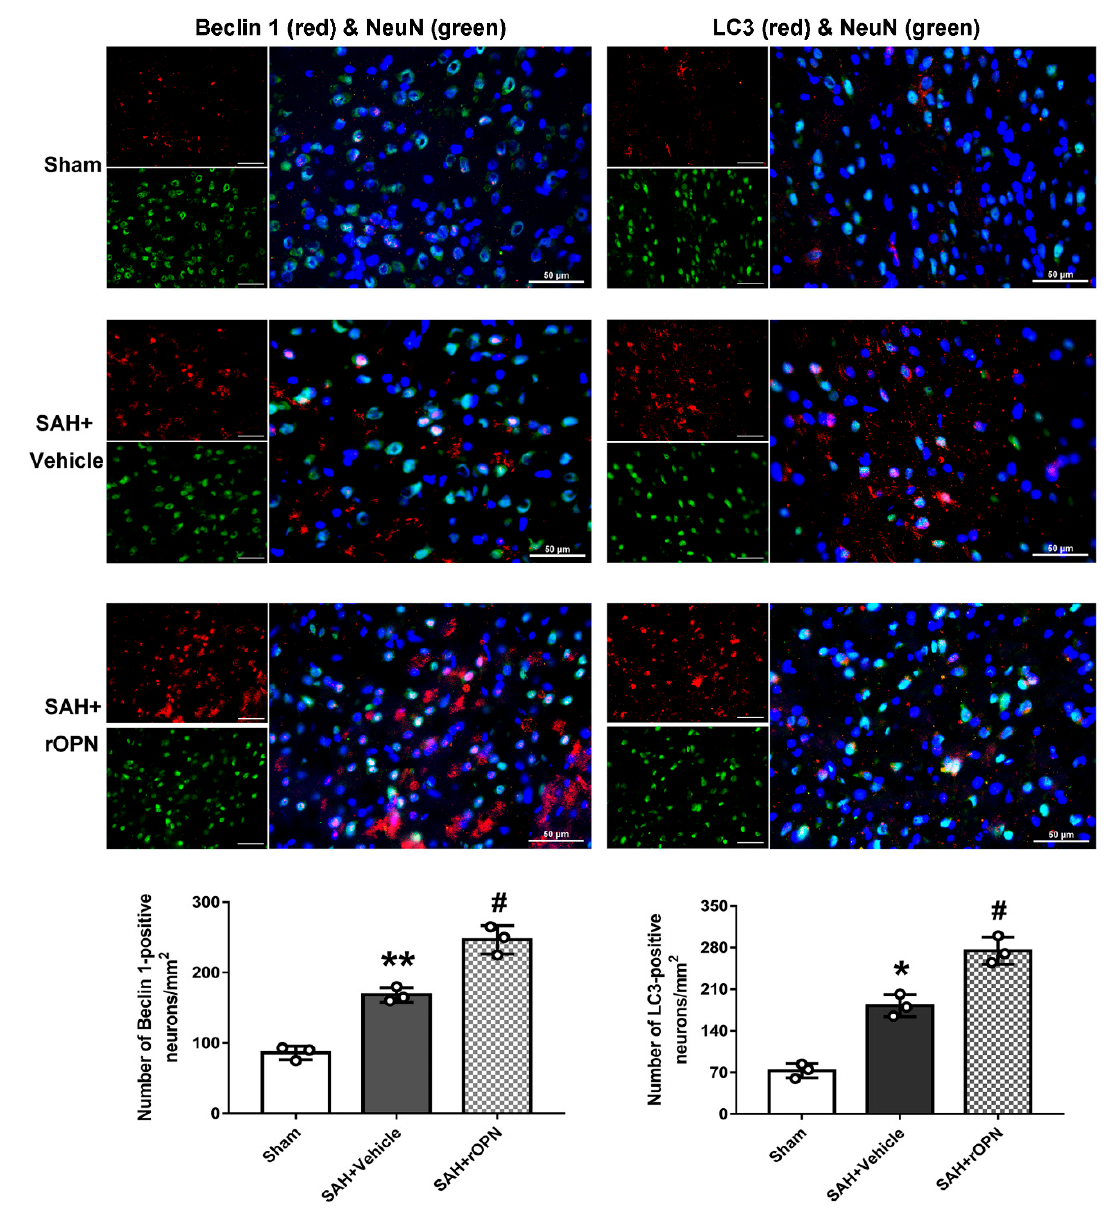
Figure 3. Nasal administration of rOPN increases the expression of Beclin 1 (red fluorescence) and LC3 (red fluorescence) in neurons (green fluorescence). Cell nuclei were counterstained with DAPI (blue fluorescence). n = 3 per group. Scale bar = 50 µ m. Data are presented as mean ± SD. * p < 0.05, ** p < 0.01 vs. Sham group; # p < 0.05, vs. SAH + Vehicle group.